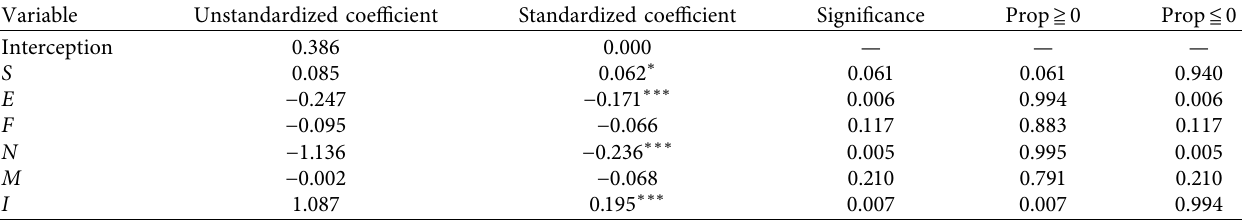
Table 8: QAP regression results of spatial association matrix R and its influencing factor